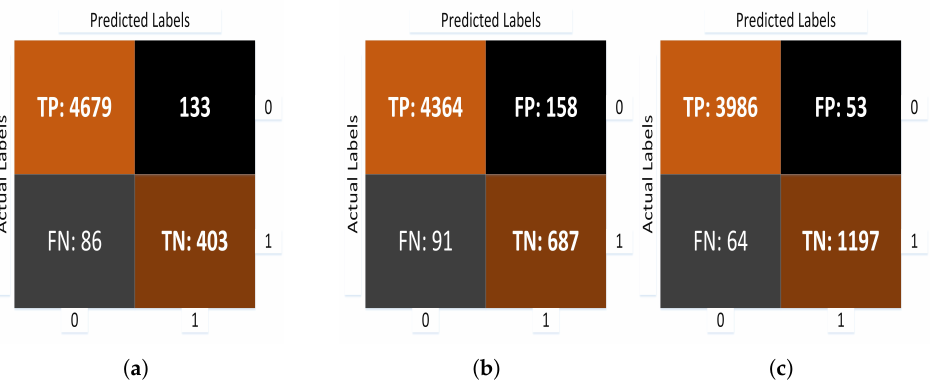
Figure 15. Confusion matrices for CNN, transfer learning, and the fine tuning-based proposed model. ( a ) Confusion matrix for CNN model. ( b ) Confusion matrix for transfer model. ( c ) Confusion matrix for fine tuning